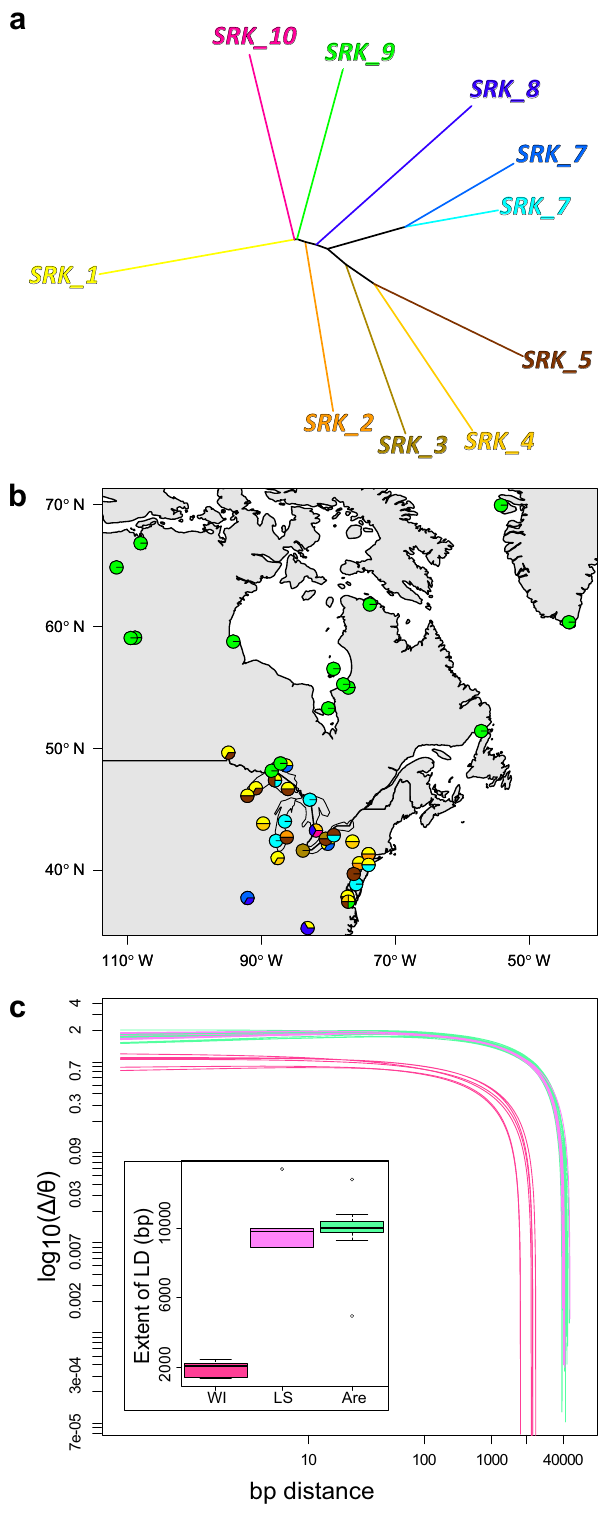
Fig. 3 | Haplotype diversity at the self-incompatibility (S-)locus, and genome- wide shift in linkage disequilibrium (LD). a Neighbor-joining tree of haplotypes of the S-locus gene SRK . b Map showing the distribution of the major haplotype groups of SRK . Haplotypes could only be reconstructed for some individuals (Sup- plementary Data 6). c Individual-based LD estimated by the correlation of zygosity ( Δ ) that was scaled by the level of genome-wide heterozygosity ( θ ). Colors depict A. lyrata individuals from Wisconsin (WI, n =6) and north shore Lake Superior (LS, n =6), and non-admixed A. arenicola ( n =15). Boxplots in the inset depict the extent of LD, estimated by the base pair (bp) distance over which the scaled log 10 -trans- formed Δ reached a low value of 0.1 (box plot elements: center line is the median, box limits are the upper and lower quartiles, whiskers the 1.5x interquartile ranges and points the outliers). Source data are provided as Source data fi